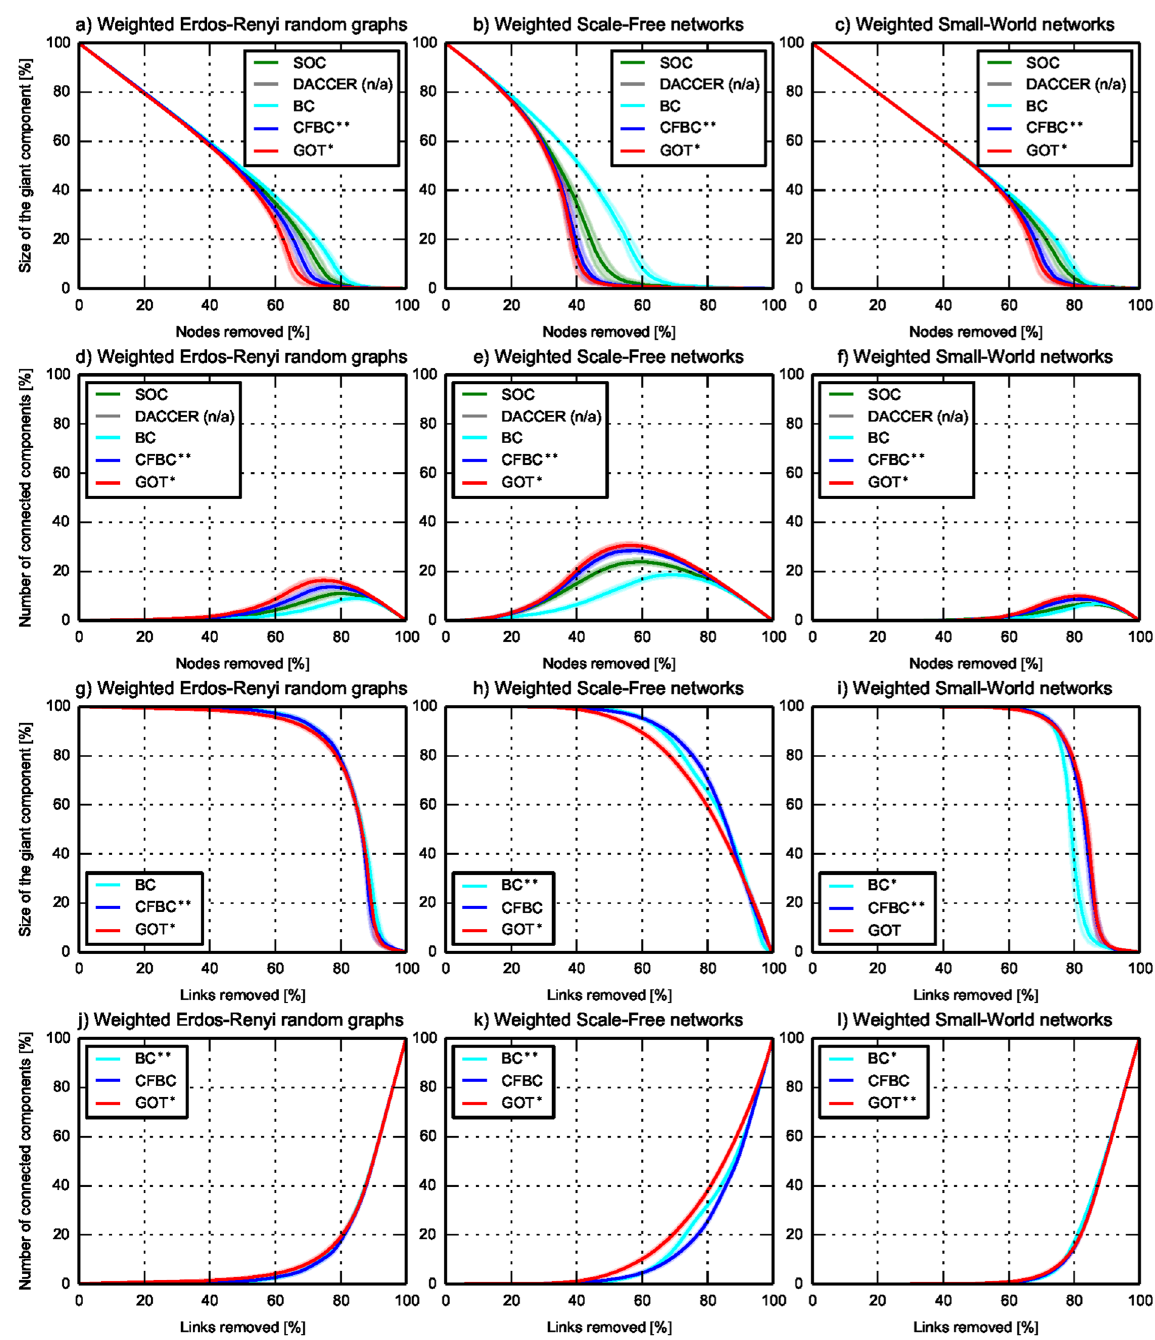
Figure 5. GOT accuracy - random generated weighted networks. The evolution of the size of the giant component and of the number of connected components with mean (the straight line) and standard deviation (the shadow area) in weighted networks during the NRP procedure, averaged over 100 networks in each subplot. The y-axes give figure of merit, while the x-axes represent percentage of node and links removals, respectively. In the top subplots, nodes centrality is assessed, while in the bottom subplots, the links centrality is